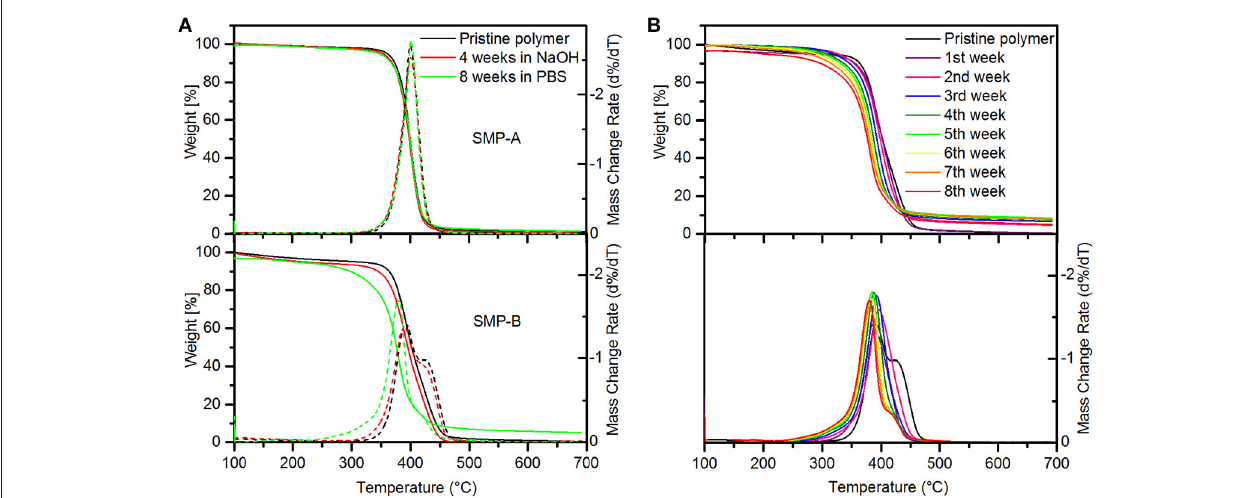
FIGURE 7 | Thermal gravimetric analysis of SMPs. (A) Showing weight loss and mass change rate of SMP-A (top) and SMP-B (bottom) after 4 weeks in 1 M NaOH solution at 37 ◦ C (red line) and 8 weeks in PBS at 75 ◦ C (green line). (B) Weight loss (top) and mass change rate (bottom) of SMP-B in PBS over 8 weeks.